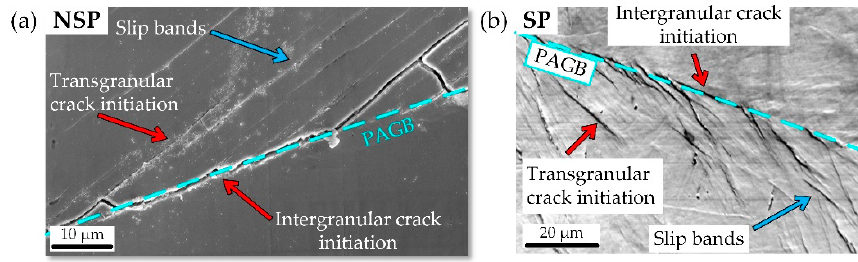
Figure 6. ( a ) Crack density ρ CD of the NSP samples and the SP samples as a function of the number of cycles for different stress amplitudes; ( b ) CLM images of two NSP samples of different stress amplitudes; ( c ) CLM images of an NSP sample and an SP sample of similar stress amplitude.